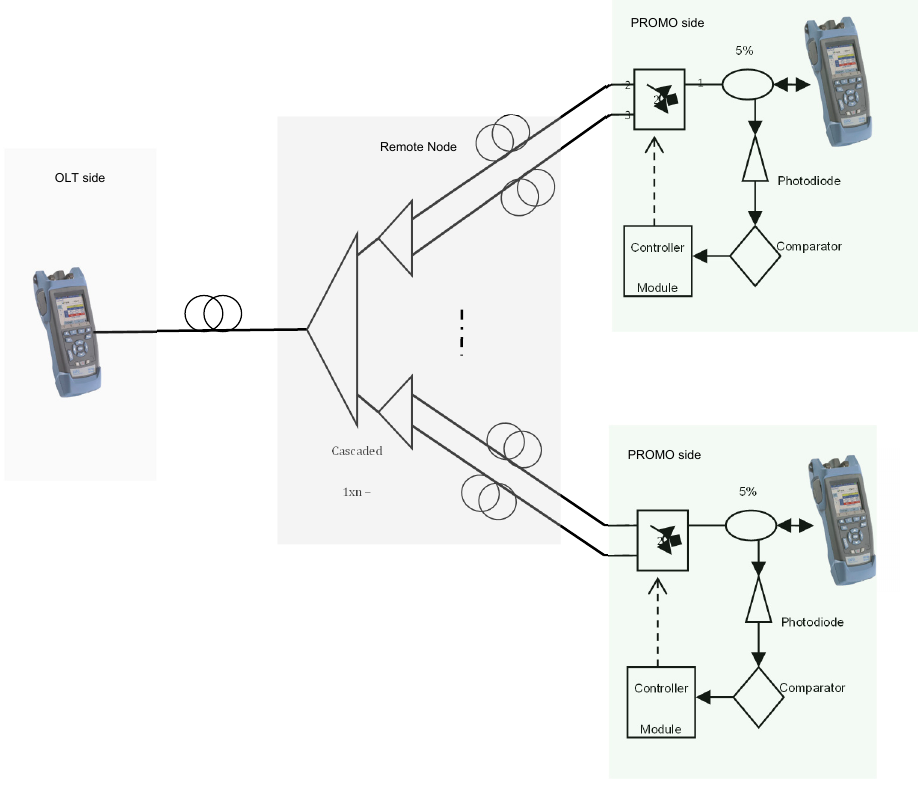
Figure 15. PROMO configuration for experiment.